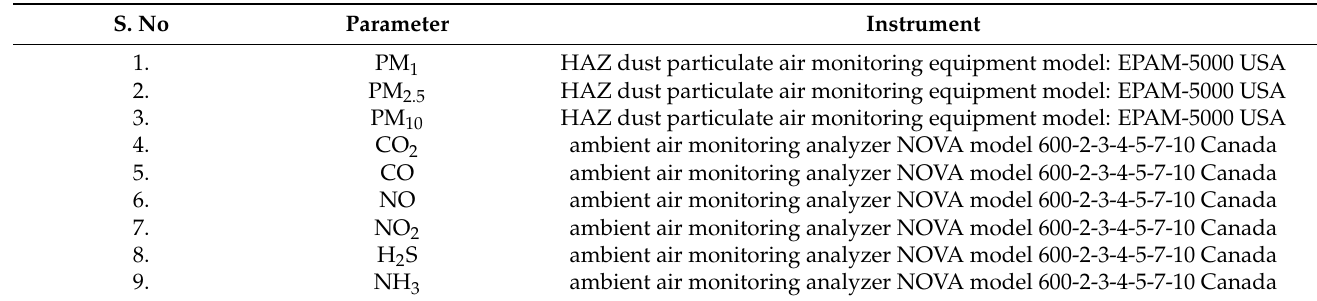
Table 2. Show different parameters and instruments for its